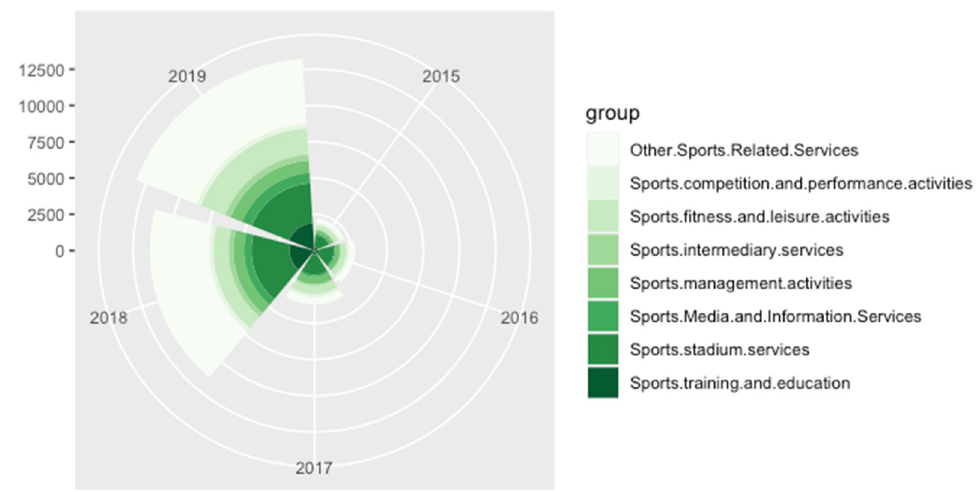
Figure 1. National sports industry of China from 2015 to 2019, data from [14].